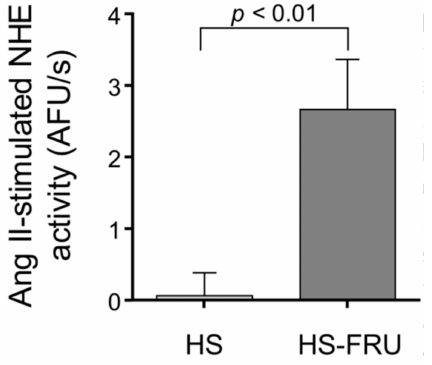
Figure 4. Effect of 10 − 12 mol/L angiotensin II Ang II on Na + /H + -exchanger (NHE) activity in proximal tubules isolated from rats fed a high-salt diet drinking tap water (HS) or 20% fructose